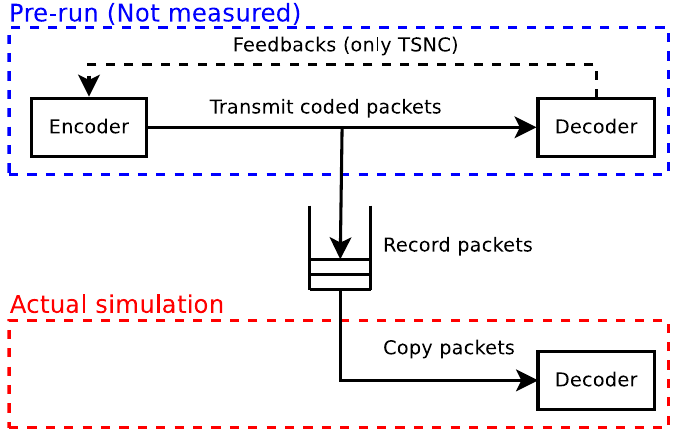
Figure 2. Decoding goodput benchmark.